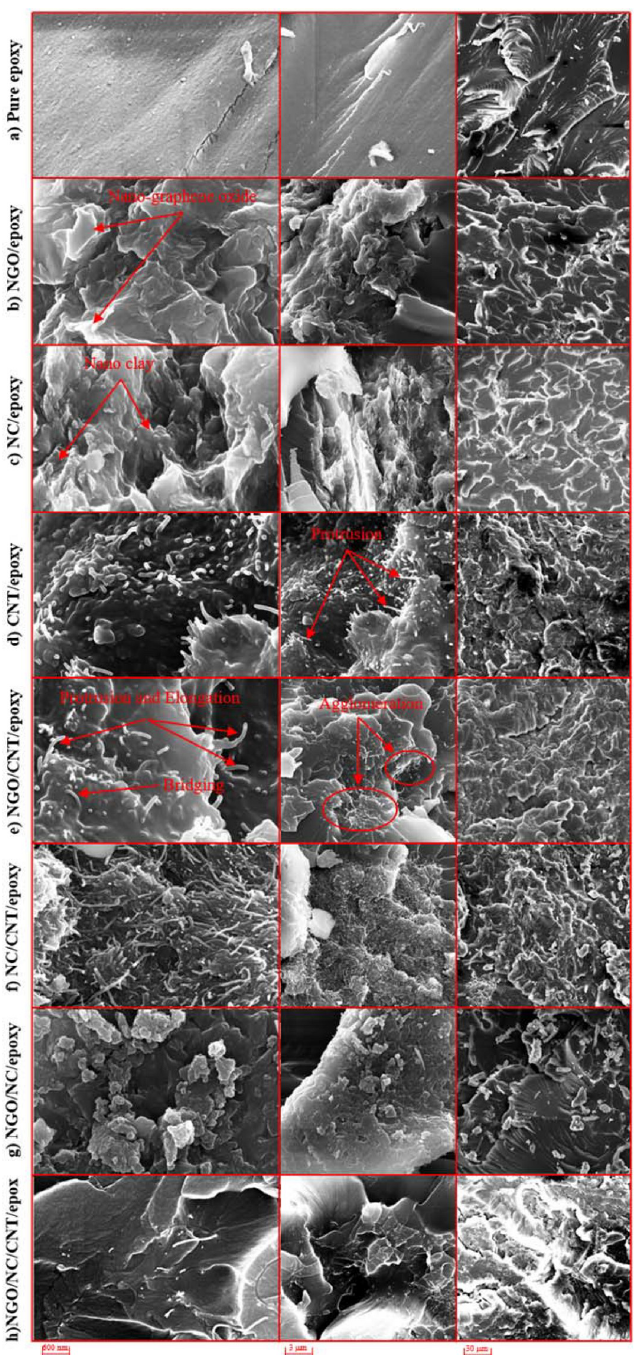
Fig 4. FESEM images of the fractured cross-sections of a) pure epoxy, b) NGO/epoxy, c) NC/epoxy, d) CNT/epoxy, e) NGO/CNT/epoxy, f) NC/CNT/epoxy, g) NGO/NC/epoxy, and h) NGO/NC/CNT/epoxy. filaments in the epoxy help to improve the tensile strength of the sample by their stretching and bending and prevent cracking in epoxy. Nevertheless, in all CNTs-containing samples, some CNTs have been pulled out of the fracture surface indicating the bridging mechanism of